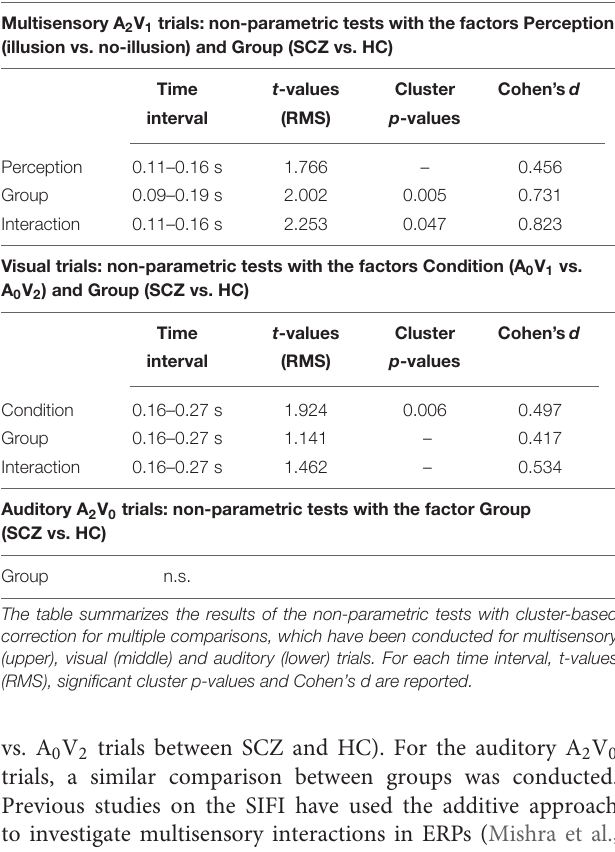
TABLE 2 | Significant findings of the non-parametric